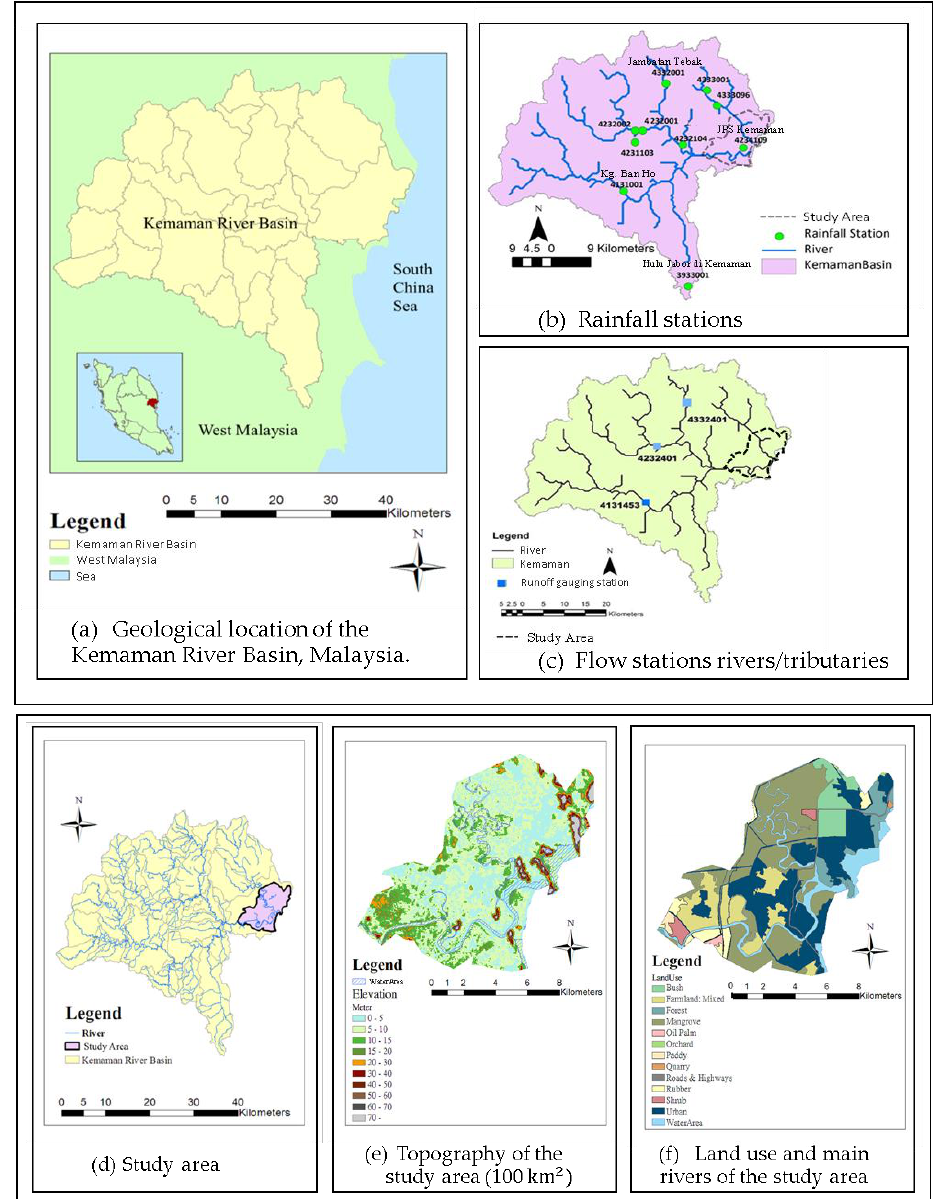
Figure 1. Information of Kemaman River Basin in Malaysia: ( a ) geological location, ( b ) rainfall stations and ( c ) river flow stations (St.), ( d ) study area, ( e ) topology of the study area, and ( f ) land use and main rivers.